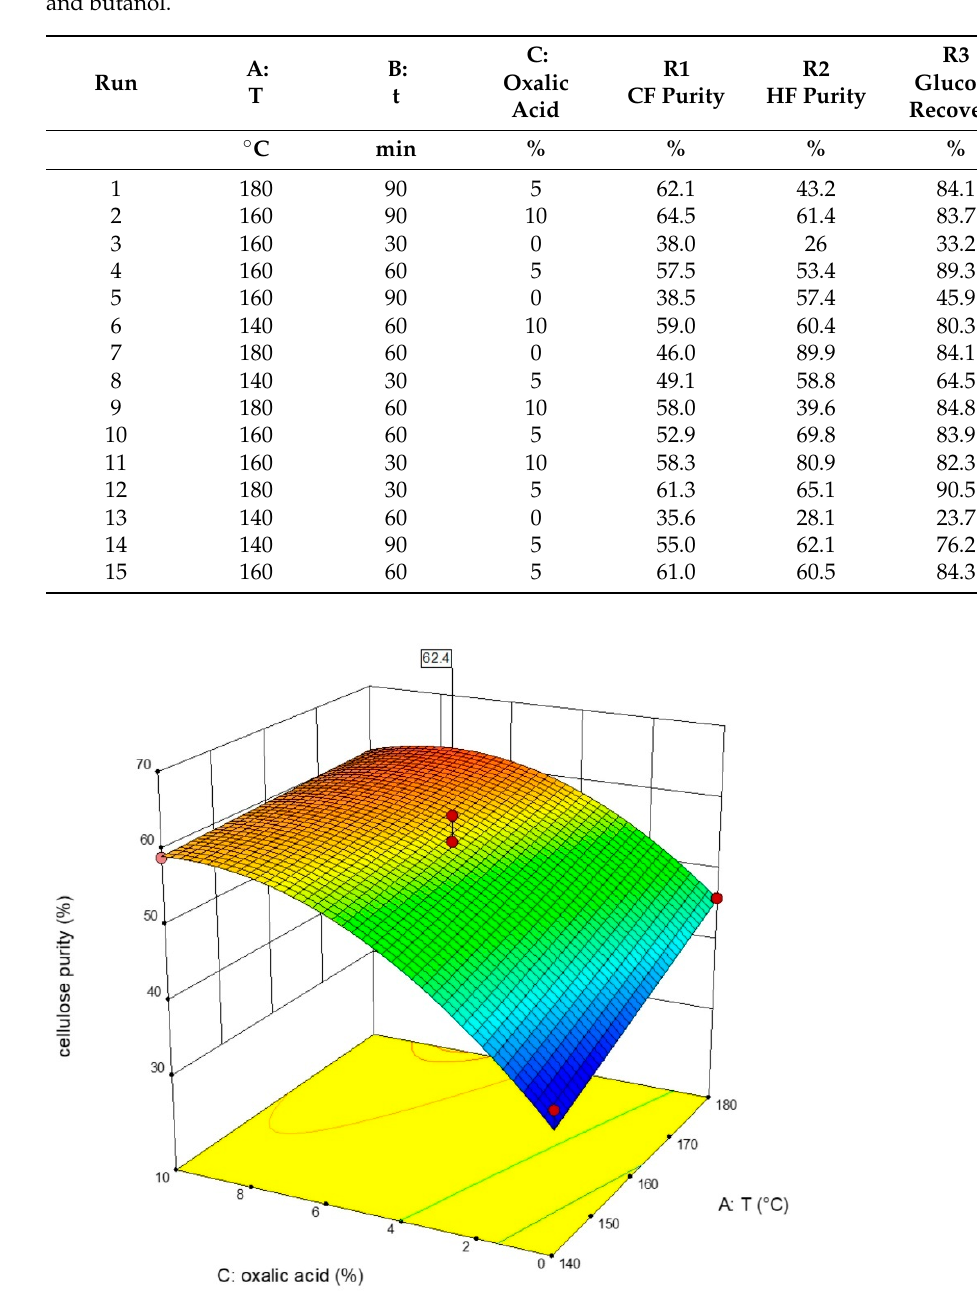
Figure 4. Purity of the CF as a function of temperature and oxalic acid obtained from WS pretreated with butanol, at 60 min. Here and in the following, the surface is the 2-order polynomial best interpolating the experimental data.